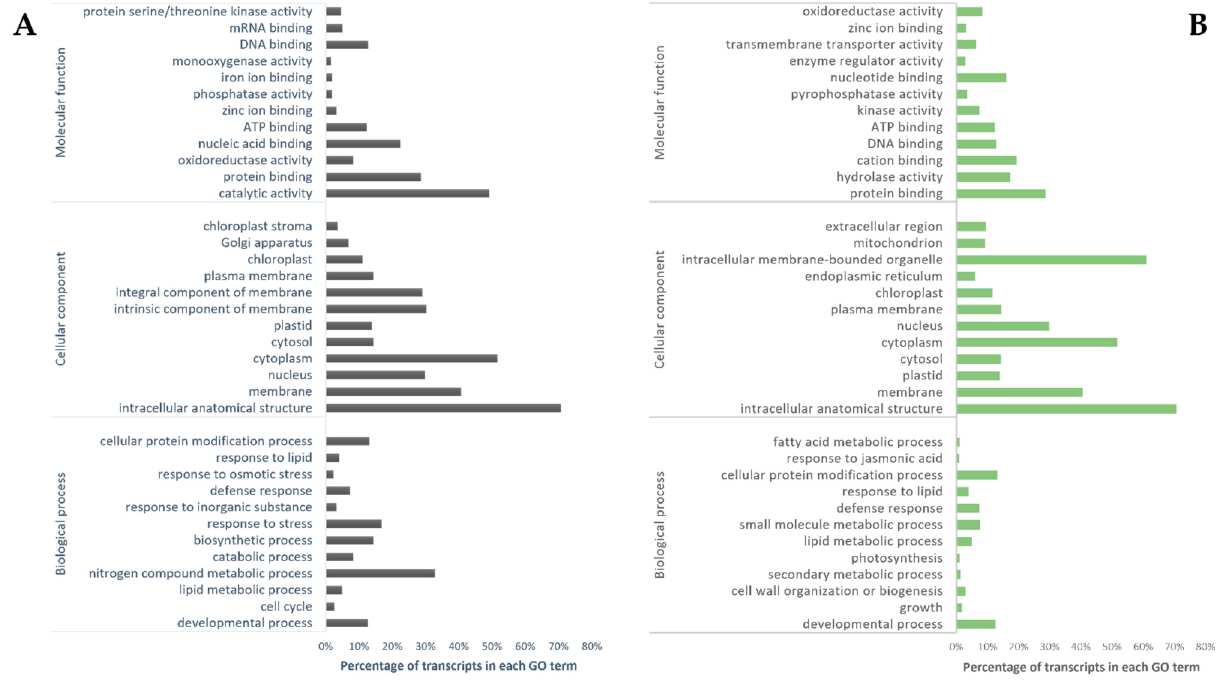
Figure 4. Top 12 GO classification of upregulated genes in roots ( A ) and aboveground parts ( B ) of H. incana under Pb exposure.